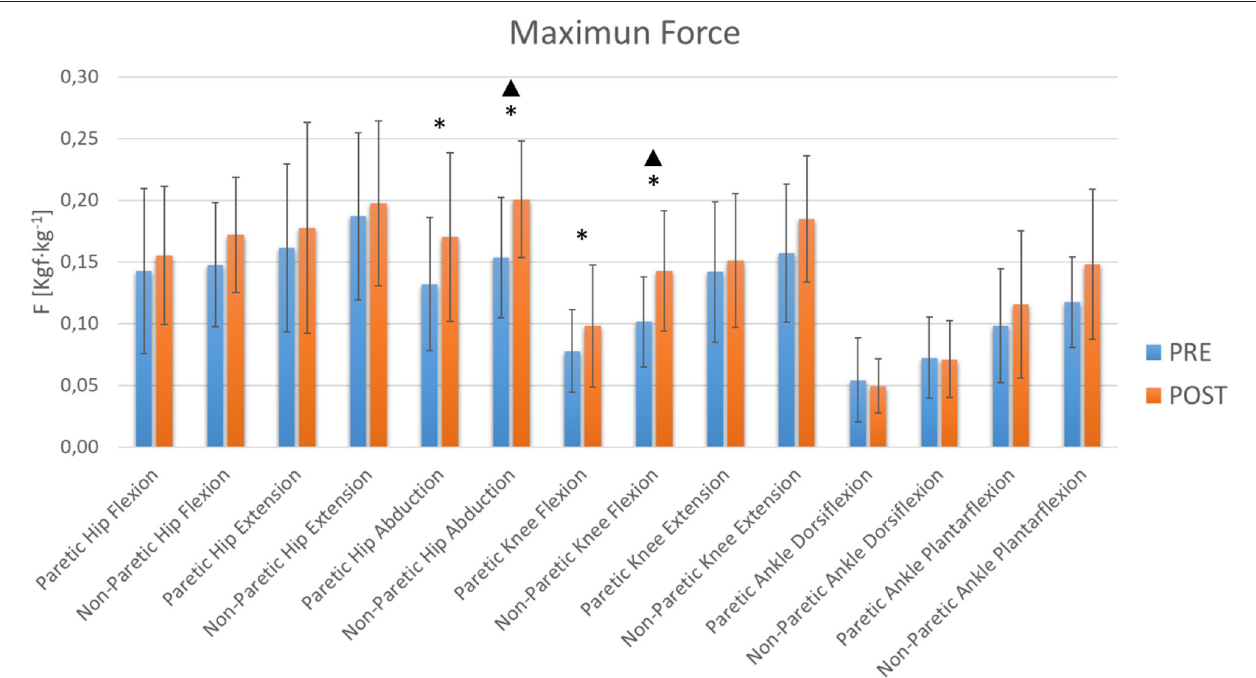
FIGURE 2 | Maximum Lower Limb Forces. The blue and orange bars show the mean value (M). The standard deviation (SD) is also shown through error bars. *Significant differences. N Statistical power > 80%.